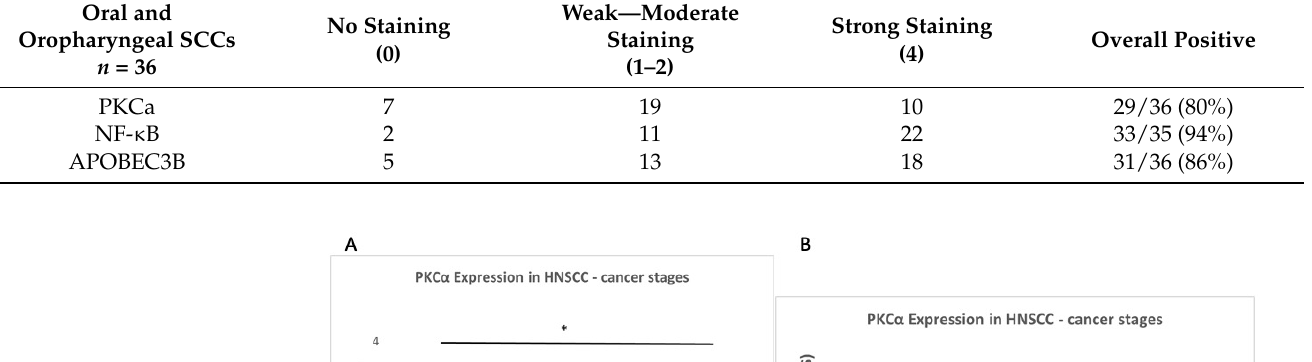
Figure 1. Immunohistochemical expression of PKC α , NF- κ B, and APOBEC3B: ( a ) cytoplasmic expression of PKC α ; ( b ) cytoplasmic expression of NF- κ B; ( c ) nuclear and cytoplasmic expression of APOBEC3B in an oral squamous cell carcinoma; ( d ) cytoplasmic expression of PKC α ; ( e ) cytoplasmic expression of NF- κ B; and ( f ) nuclear and cytoplasmic expression of APOBEC3B in an oropharyngeal squamous cell carcinoma (initial magnification ×40). Table 2. PKCa, NF- κ B and APOBEC3B protein expression in oral and oropharyngeal squamous cell carcinomas.